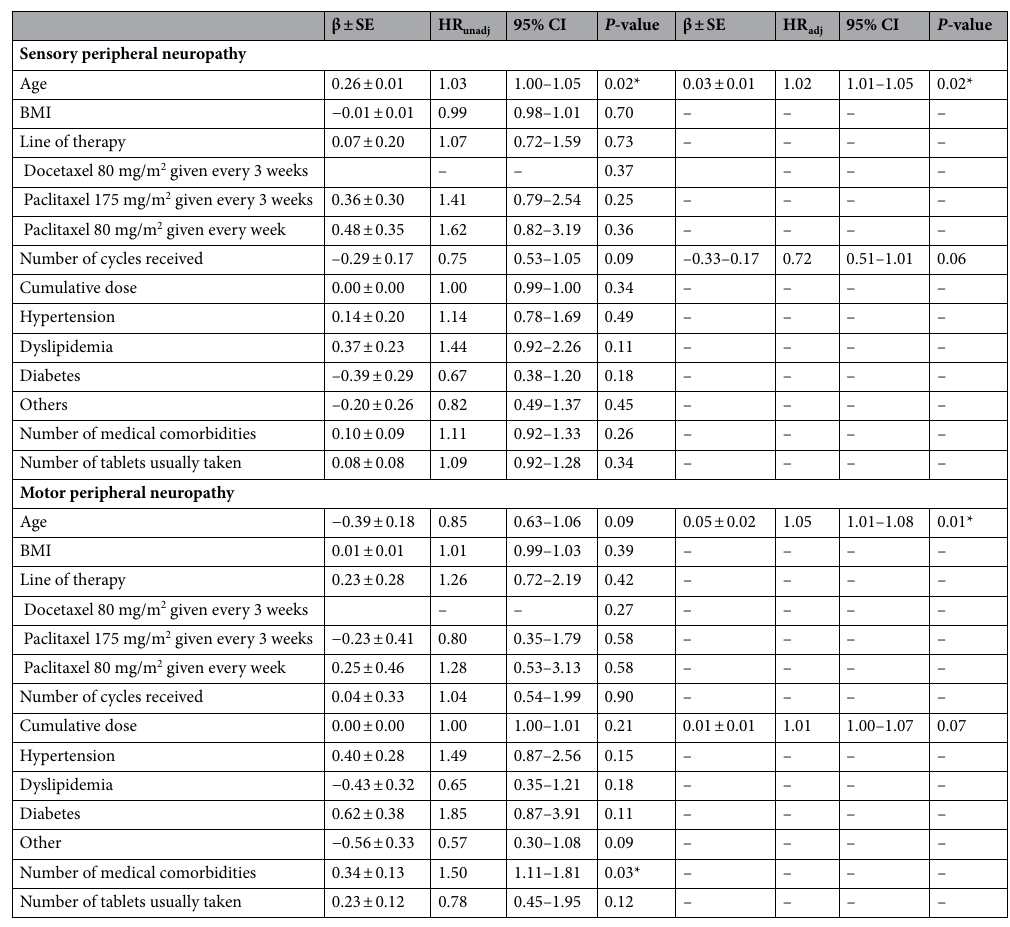
Table 3. Cox multivariate model for factors associated with TIPN symptoms. TIPN taxane-induced peripheral neuropathy. *Statistically